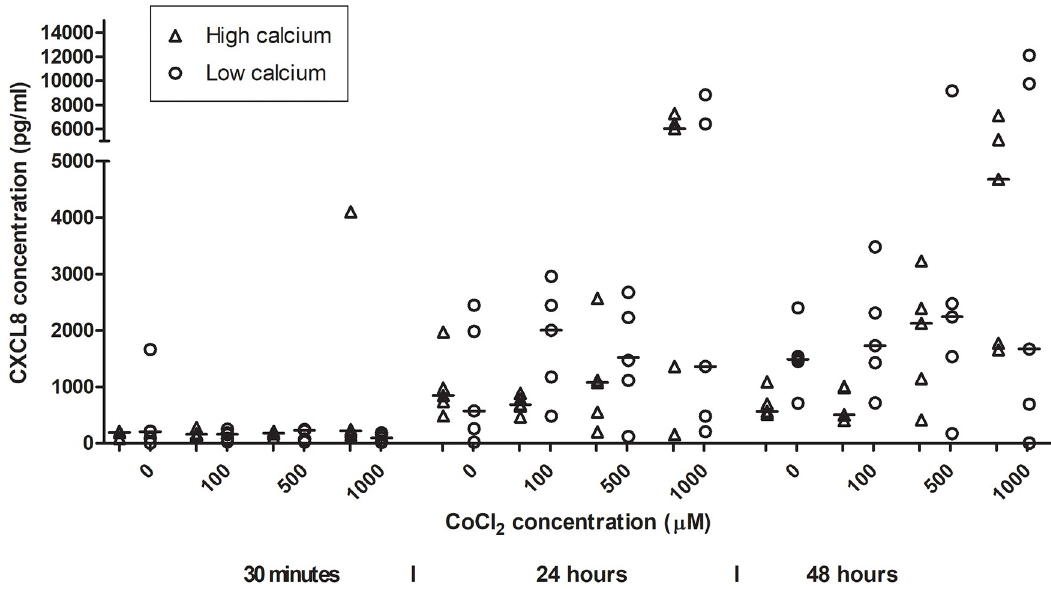
Fig 4. CXCL8 secretion from HaCaT-cells after cobalt chloride exposure. HaCaT-cells are exposed to cobalt chloride concentrations 100, 500, 1000 μ M and an unexposed control (0 μ M) at time points 30 minutes, 24 hours and 48 hours. Increase in CXCL secretion is seen for high (1.8 mM) and (low 0.15 mM) calcium culturing conditions.